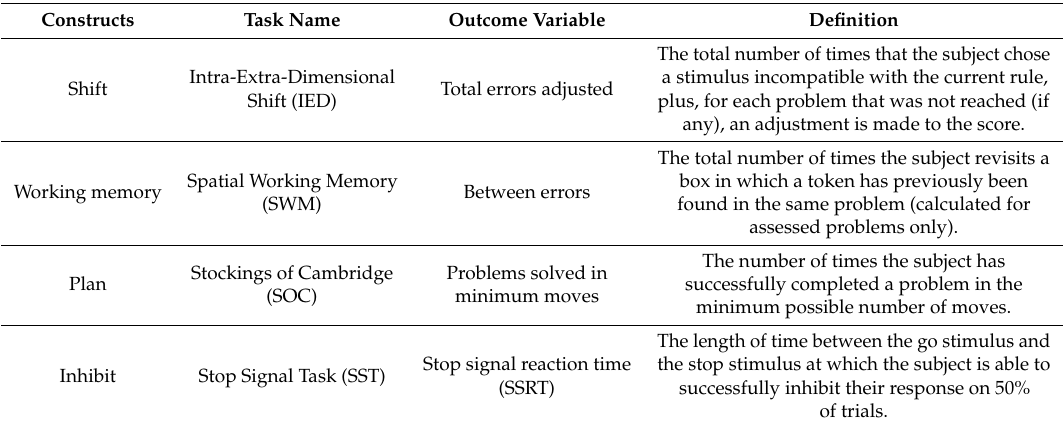
Table 2. Definitions of the key outcome measures of the Cambridge Neuropsychological Test Automated Battery